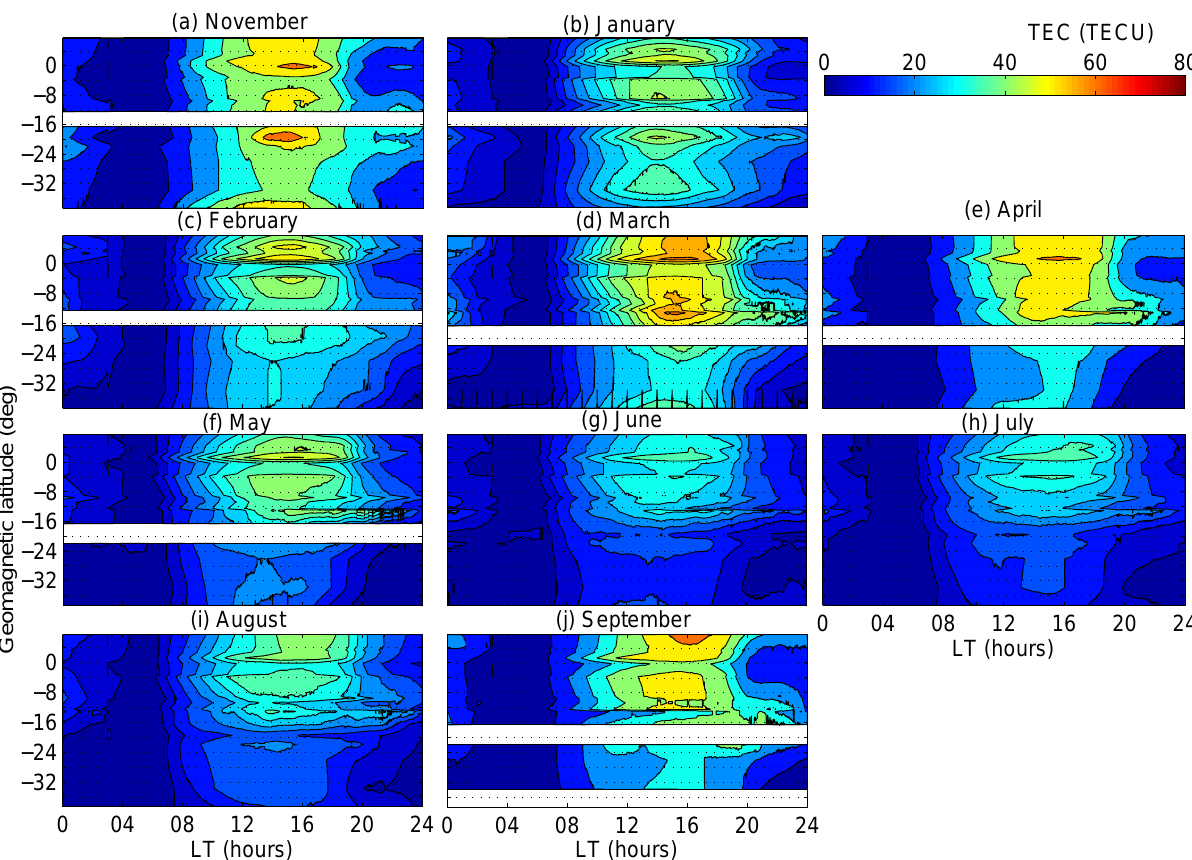
Figure 2. Contour plots of monthly mean TEC as a function of latitude and LT. (a–j) are for November and January–September.